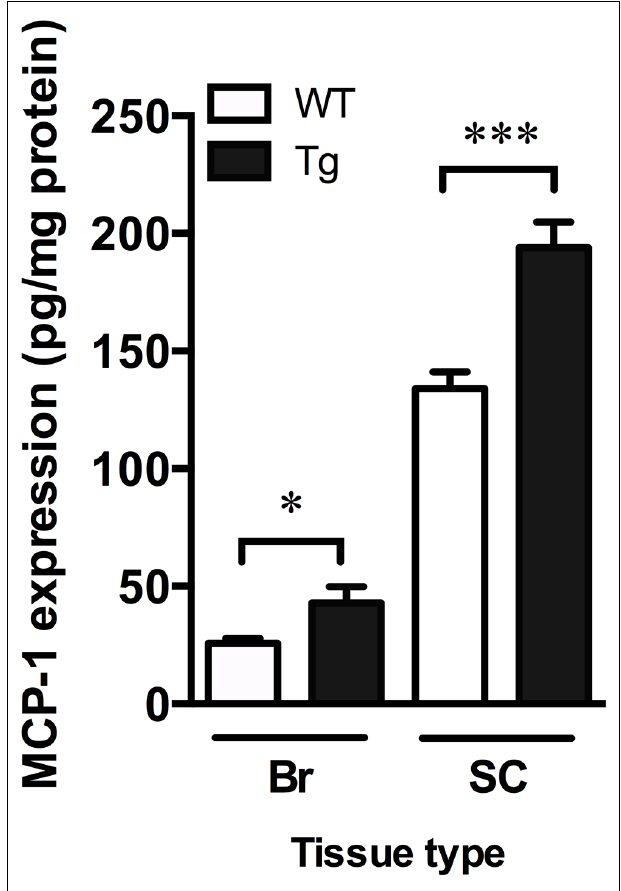
FIGURE 4 | Increased markers of inflammation inTDP-43 A315T mice. MCP-1 ELISA show a significant increase in MCP-1 content in the brain (Br) and spinal cord (SC) ofTDP-43 A315T mice (Tg) compared to wild-type (WT). *** p < 0.001; * p < 0.05. n = 9 per genotype for brain; n = 7 per genotype for spinal